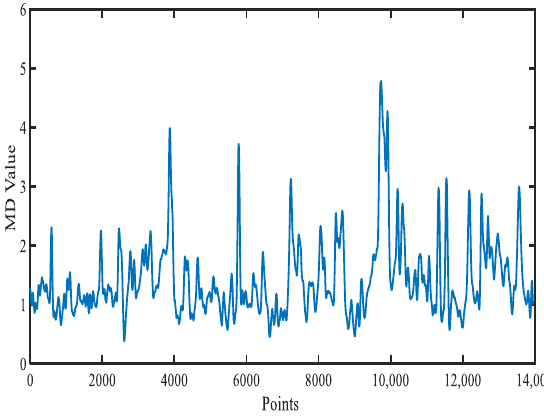
Figure 8. Actual air temperature in the wind farm.